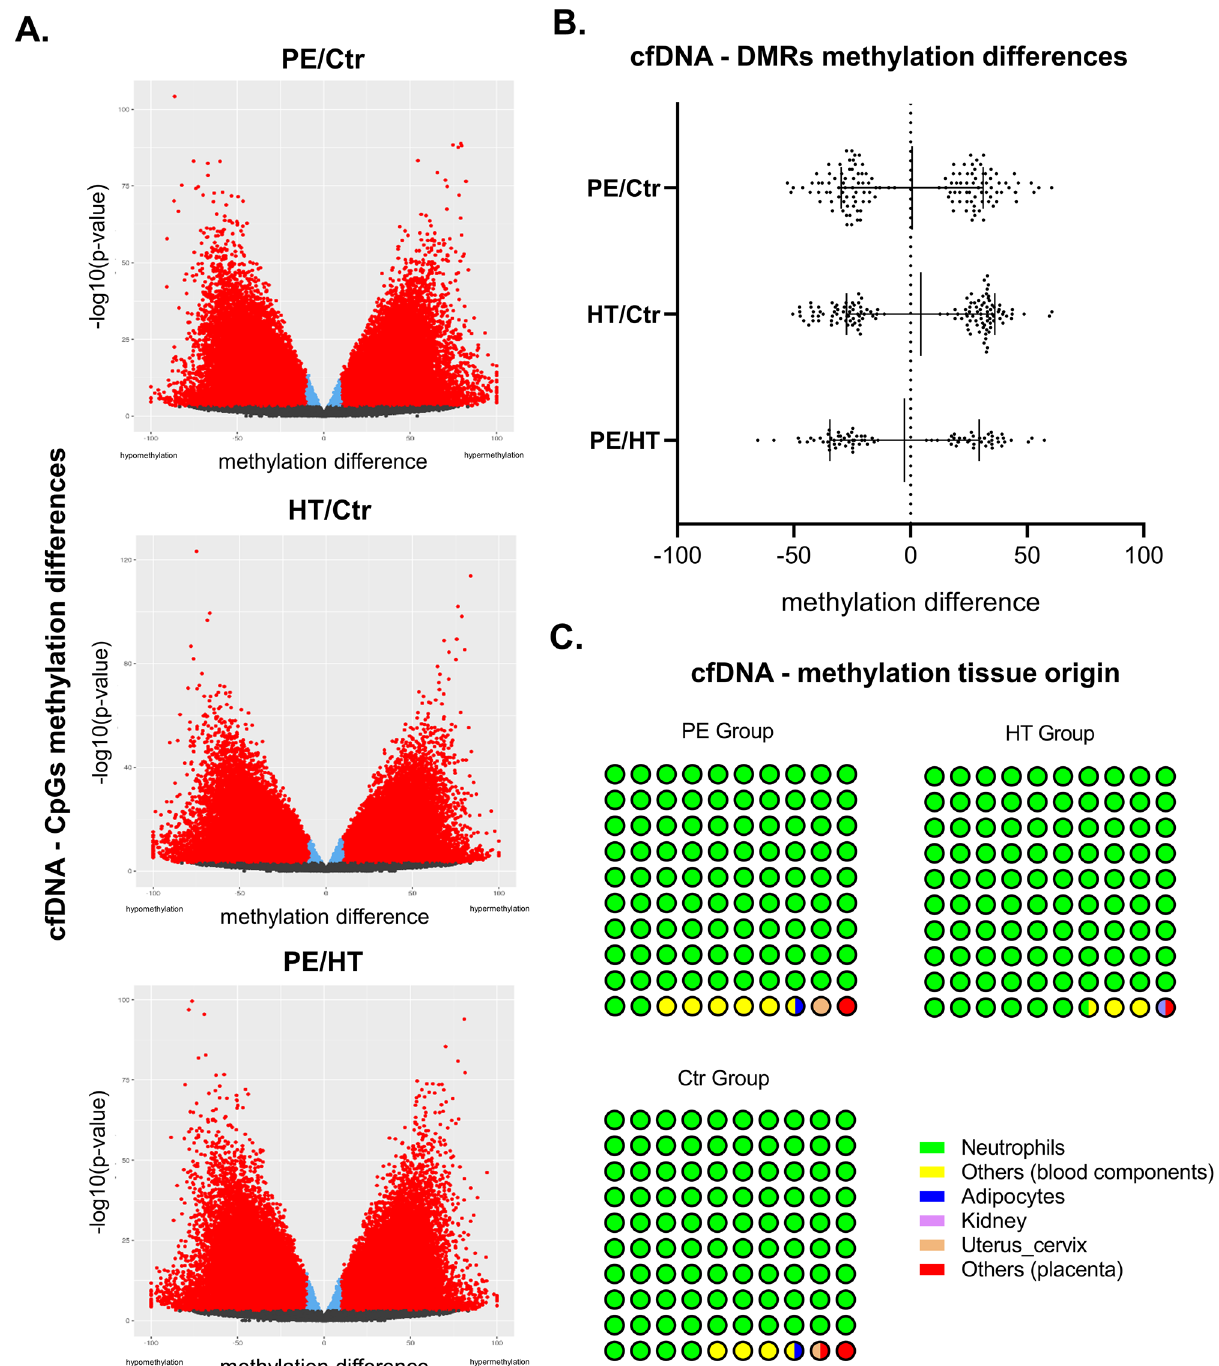
Figure 2. cfDNA methylation changes in the selected groups, n = 5 for each group. ( A ) Volcano plots visualizing the CpGs pairwise comparisons. On the x -axis is the difference in average methylation and y -axis the p value (-log10). All CpGs are shown as points: black—not significant; red or blue—significant (the adjusted p value is < 0.05). All CpGs shown in red have a methylation difference ≥ 10%. ( B ) Plots visualizing DMRs pairwise comparisons. On the x -axis is the pairwise comparison and y -axis the methylation difference. All DMRs are shown as points and differences significant (the adjusted p value is < 0.05). ( C ): Plots visualizing the predicted cfDNA source. Each dot symbolizes 1% and the legend summarizes the predicted methylation origin. Statistical processing was performed using GraphPad Prism and R Software, specifically the “ggplot2” package 58,62 . Differentially Methylated Regions (DMR); Preeclampsia (PE) Hypertension (HT); Control